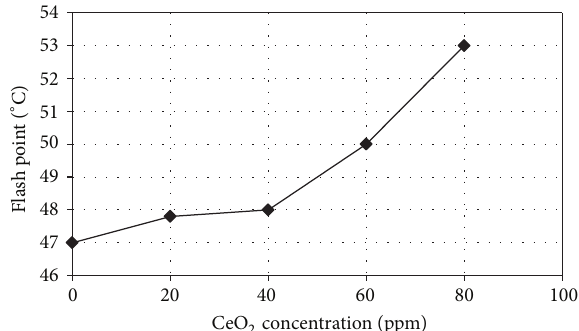
Figure 5: Variation of flash point of diesel as a function of concen- tration of cerium oxide nanoparticles.